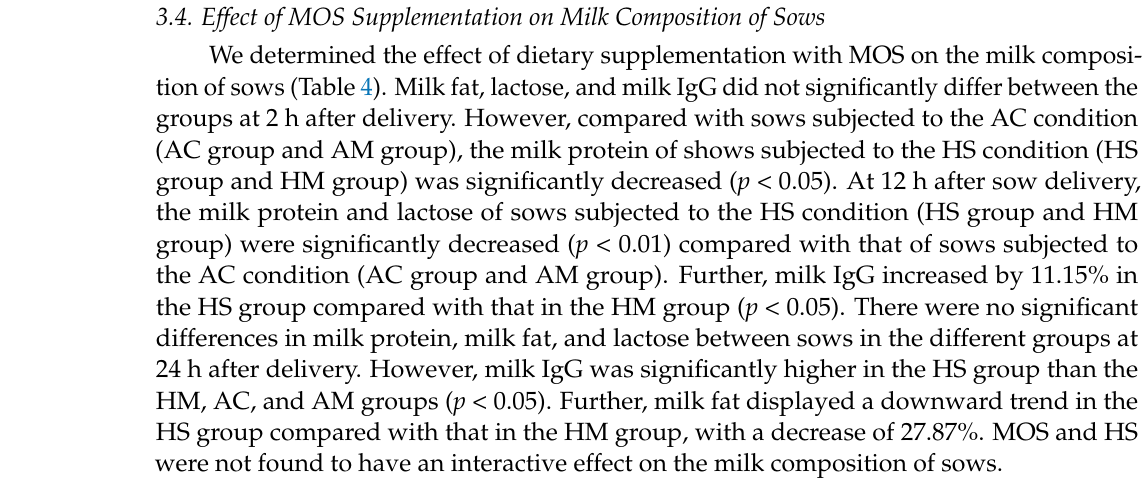
Table 4. Effects of dietary supplementation with MOS on the milk composition of sows subjected to the HS and AC